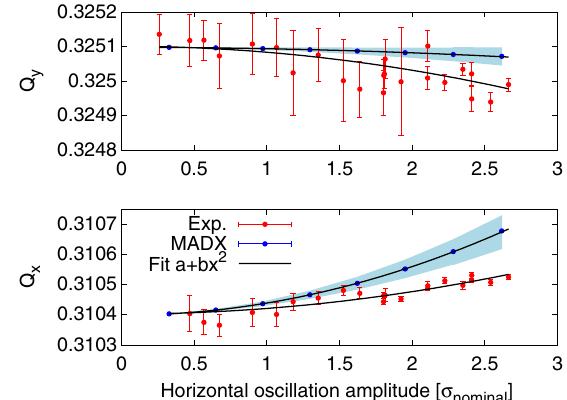
FIG. 13. Beam 2 amplitude detuning measured with horizontal ac dipole excitation for squeezed optics with (cid:3) (cid:8) ¼ 0 : 6 m . The blue dots represent tracking from MAD-X using the experimental conditions. (cid:6) nominal represents the LHC nominal rms beam size for an emittance of 3 : 75 (cid:8) m . The uncertainty due to coupling is illustrated by the light blue